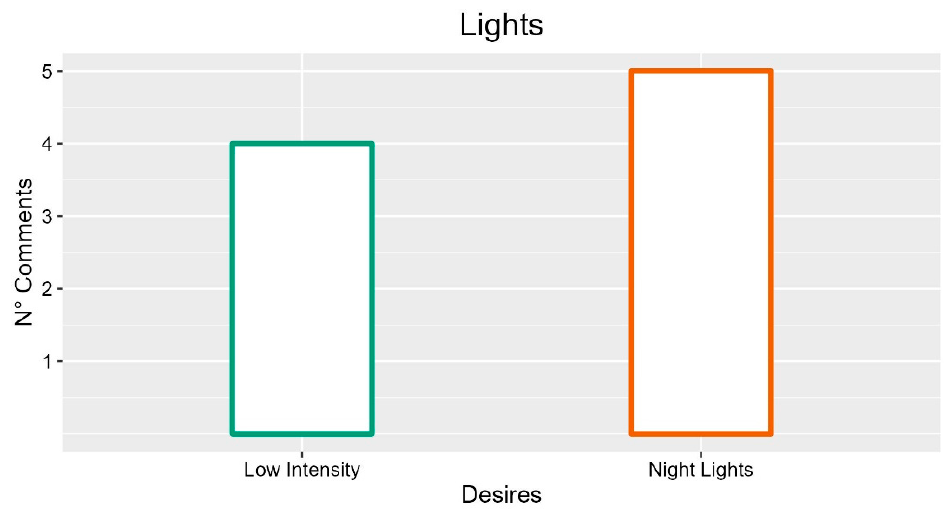
Figure 16. Graphical representation of desires with more occurrences for the Lights theme.